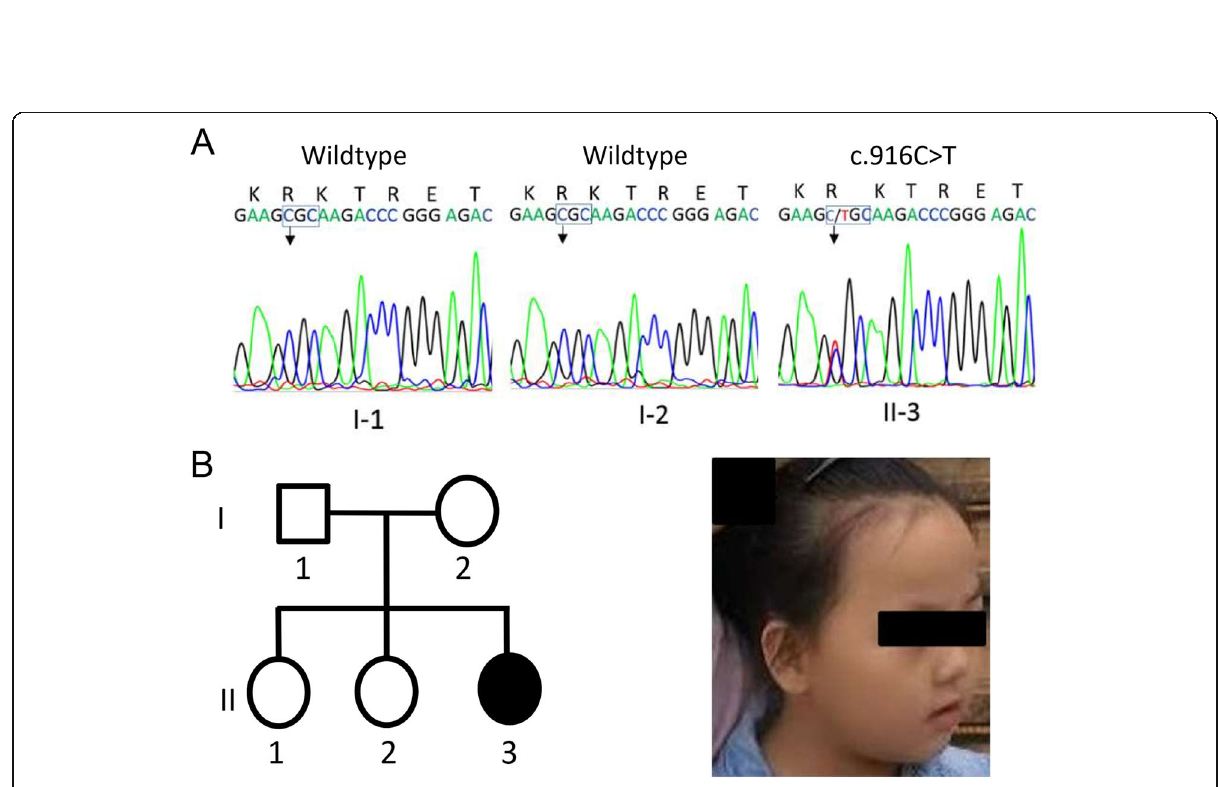
Fig. 2 Sanger sequencing of the mutation c.916C > T, p.(Arg360Cys) of MECP2 in case 2. a The mutation is present in the proband, but not in the parents, is confirmed by Sanger sequencing. b Pedigree of the family and facial photograph of the proband at 8 years